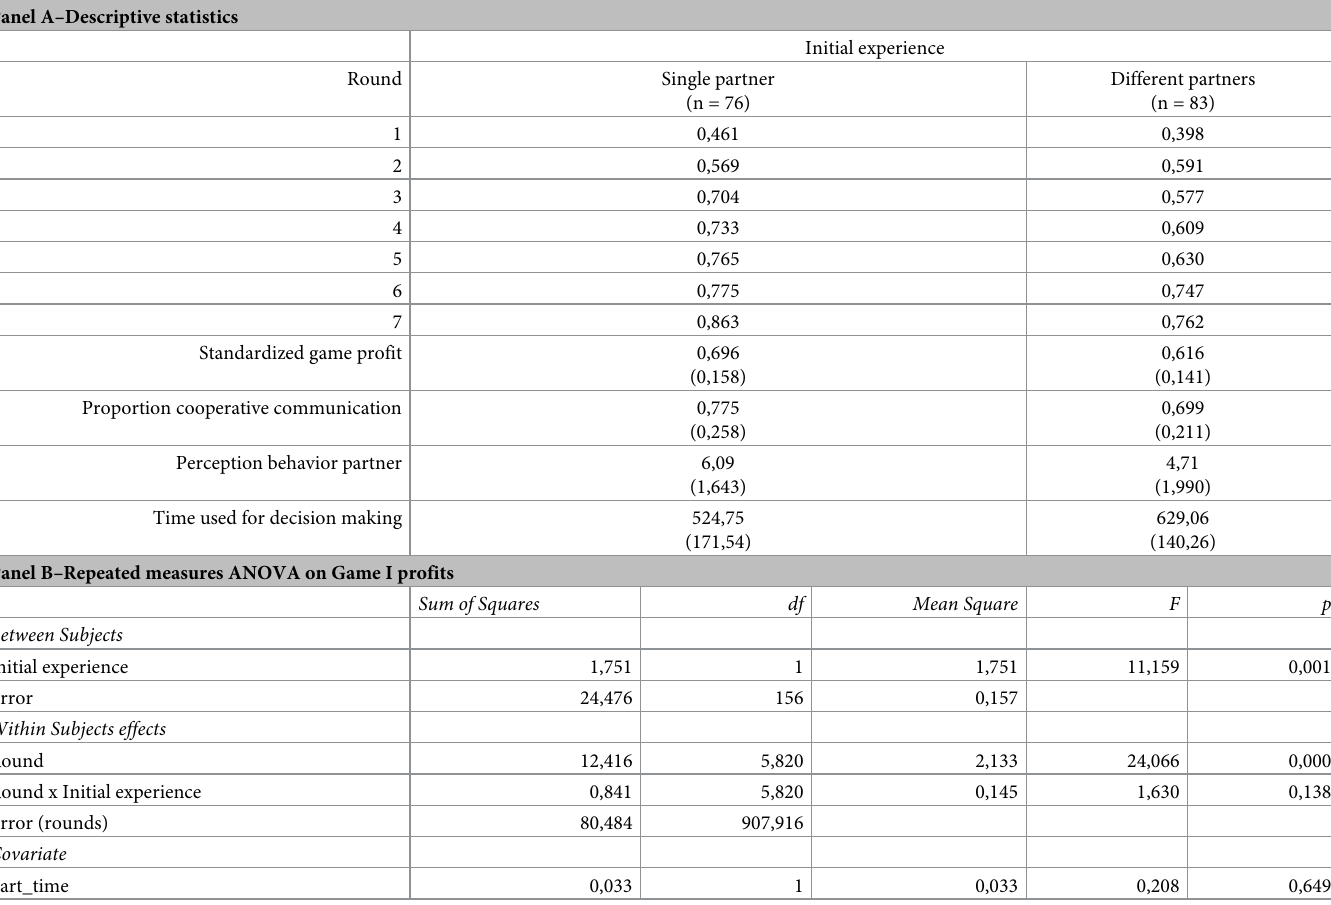
Table 3. Results on profits for partnering treatments game